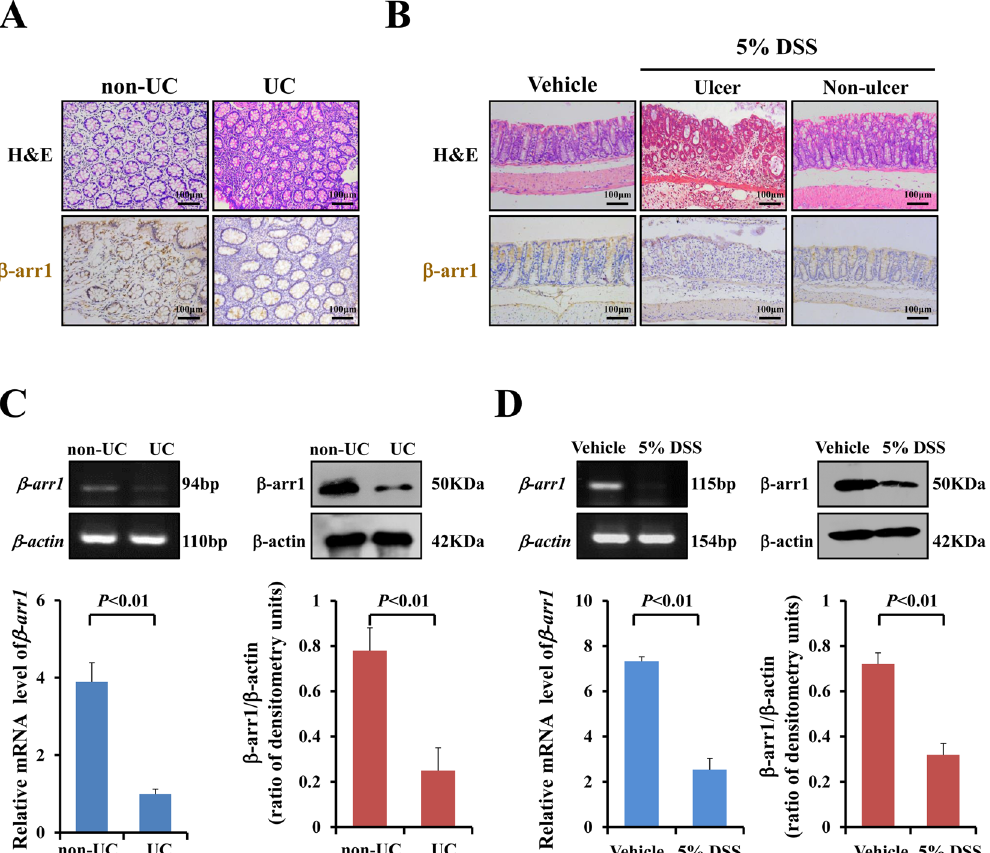
Figure 3. β -arr1 is downregulated in active colitis. ( A ) Immunostaining of β -arr1 in human colonic mucosa in the healthy volunteer group and UC group (brown, × 200). (n = 4 in each group). ( B ) Immunostaining of β -arr1 in mouse colonic mucosa in the control group, and ulcer sections and non-ulcer sections in the DSS group (brown, × 200). (n = 6 in each group). ( C ) The expression of intestinal mucosal β -arr1 mRNA and protein was evaluated in human colonic mucosa in the healthy volunteer group and UC group using real-time PCR and western blotting. Values are expressed as the mean ± SD. (n = 6 in each group). * P < 0.01 versus control group. ( D ) The expression of intestinal mucosal β -arr1 mRNA and protein was evaluated in the mouse colonic mucosa in the control group and DSS group using real-time PCR and western blotting. Values are expressed as the mean ± SD. (n = 6 in each group). * P < 0.01 versus vehicle mice. DSS: dextran sulfate sodium; Non-UC: healthy volunteers; UC: ulcerative